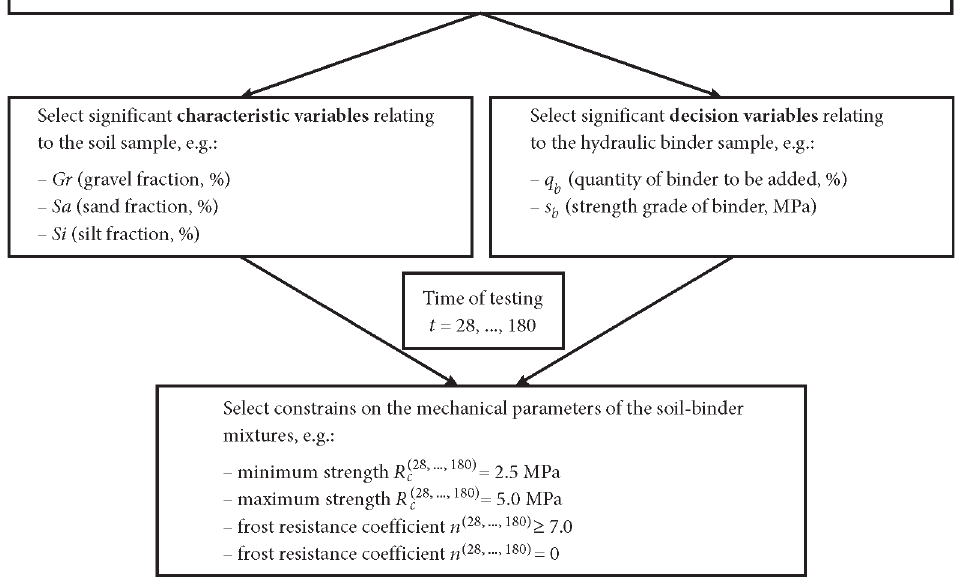
Fig. 1. Process of designing a soil-binder mixture with defined compressive strength and frost resistance coefficient